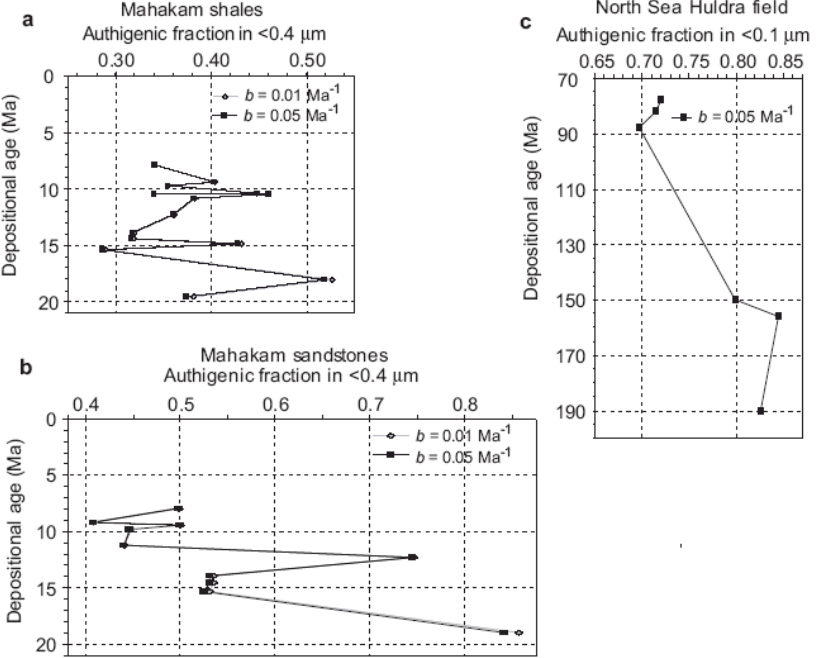
Figure 4. Interpretation of the 40 Ar/ 40 K ratios and K-Ar apparent ages of fine-grained clay size fractions in the three formations as products of mixing of small-sized particles occurring in the coarse-grained fractions (Figure 1) and the calculated authigenic particles at the same depth in sediment (Figures 5–7) that gain K at the rate b (Ma − 1 ) shown in: ( a ) the Mahakam Delta shales; ( b ) the Mahakam Delta sandstones; ( c ) the North Sea section.